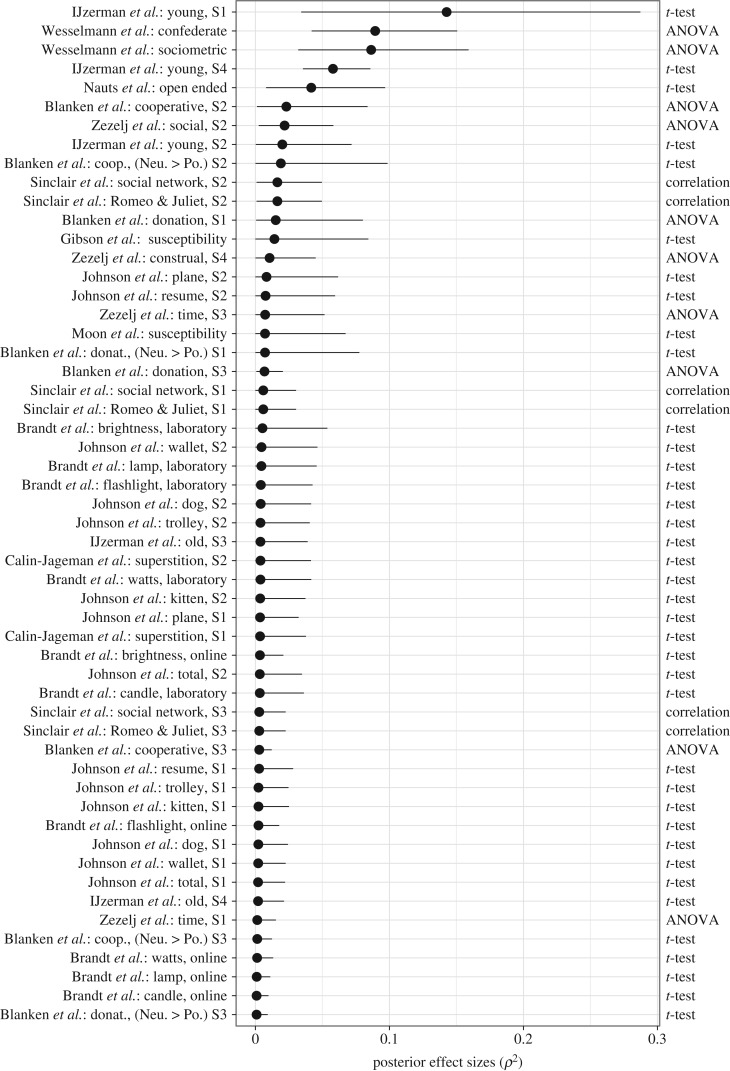
Individual Bayesian parameter estimation results for undirected effect sizes ρ2 for each of 54 experiments reported in the Social Psychology special issue that used either t-tests, correlation tests or ANOVAs. The posterior medians are indicated as dots and the central 95% credible intervals as vertical lines. The effect sizes were estimated using an unrestricted model. Figure available at https://flic.kr/p/FJSqwH, under CC license https://creativecommons.org/licenses/by/2.0/.